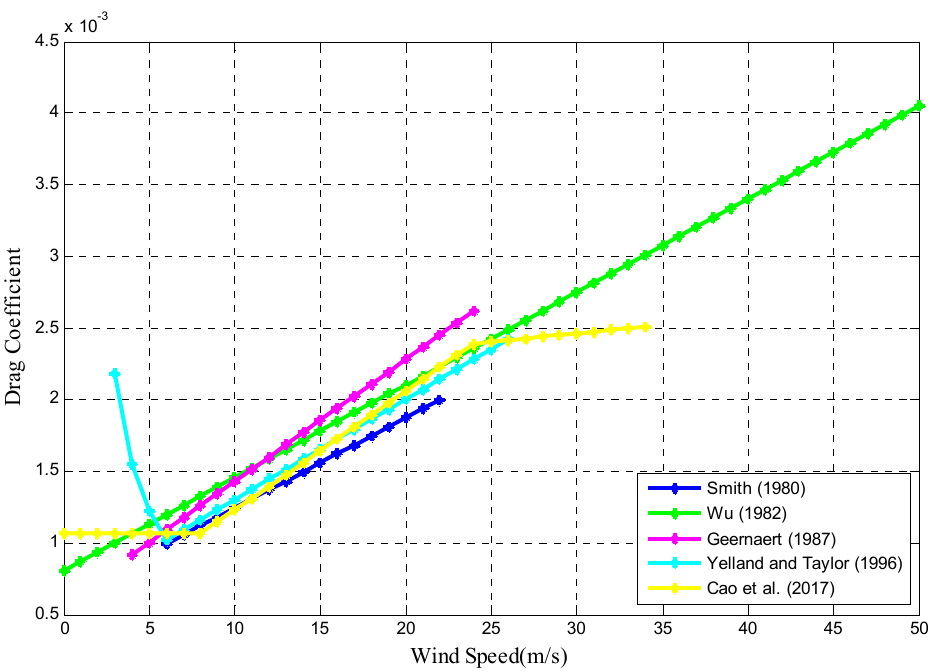
Figure 2. Five drag coefficients as a function of wind speed at 10 m above the sea surface from the work of Smith (1980), Wu (1982), Geernaert (1987), Yelland and Taylor (1996), and Cao et al. (2017).